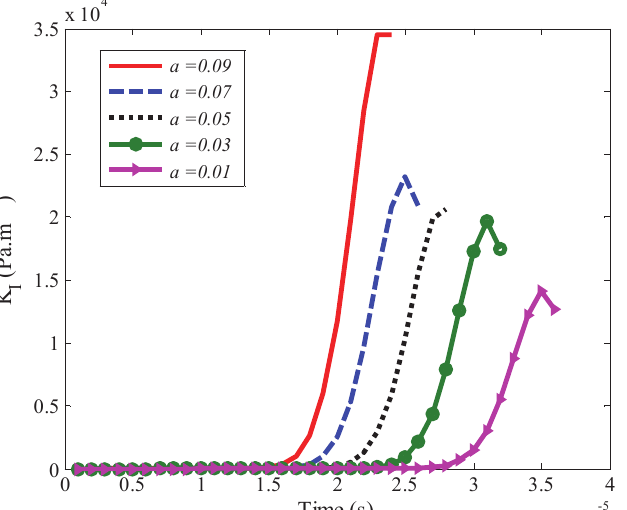
Figure 12: Plots of SIF vs. time for circumferential crack with various depths embedded in a FG cylinder under impulsive tension.